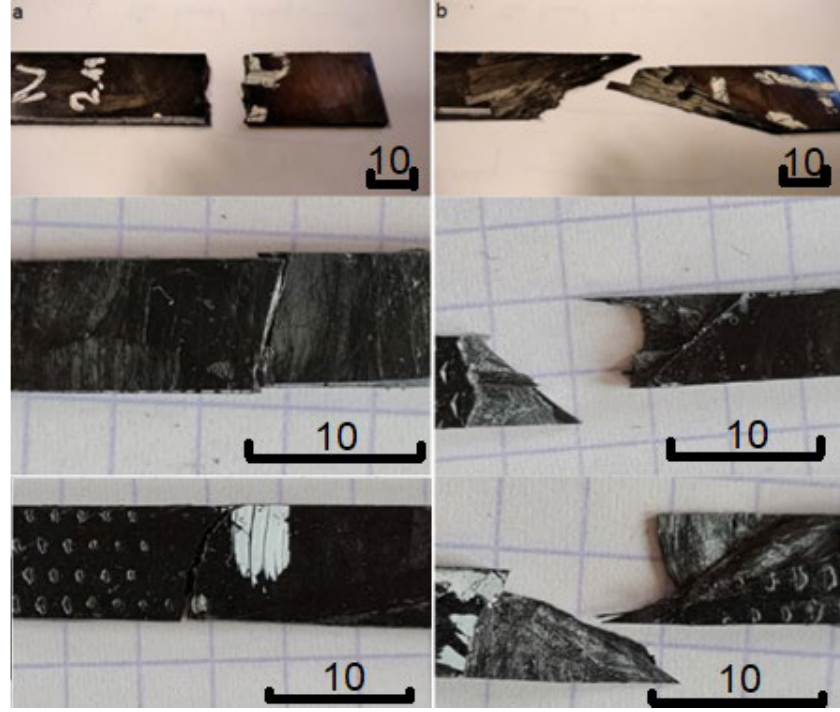
Figure 9. Destruction of composite samples after tensile tests: ( a ) representative samples of the laminate reinforced with the pyrolytic fibers (series 2 from Table 1), ( b ) representative samples of the laminate reinforced with the original carbon fibers (series 3 from Table 1) .